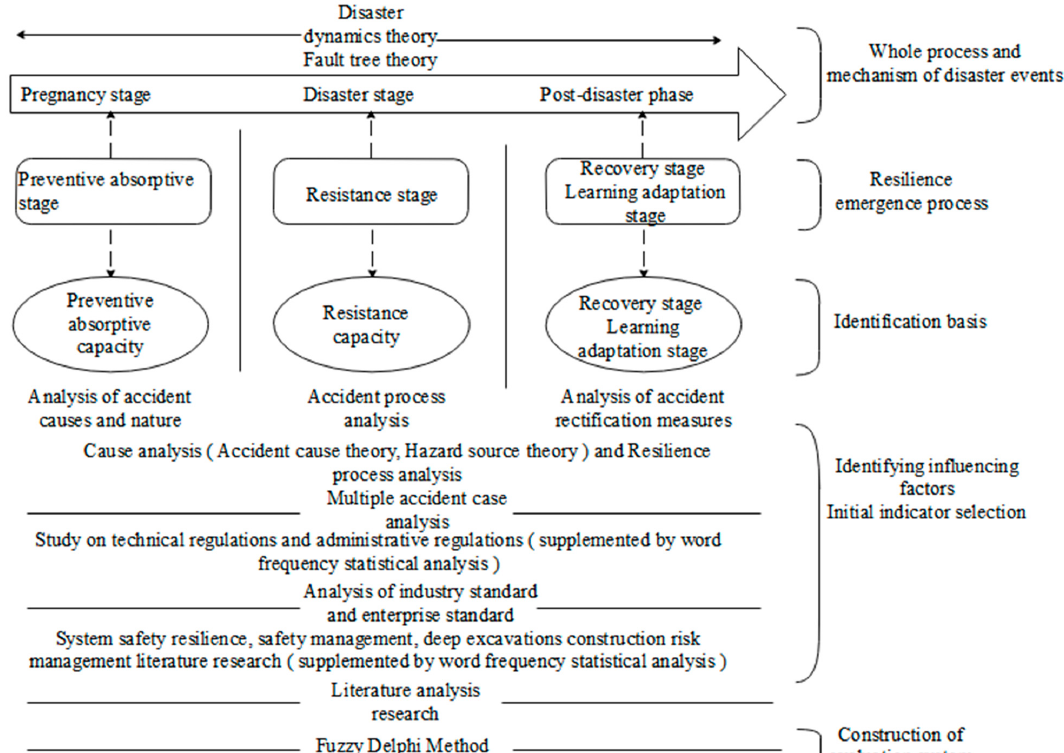
Figure 1. Composition and synergy diagram of deep excavations construction safety system.